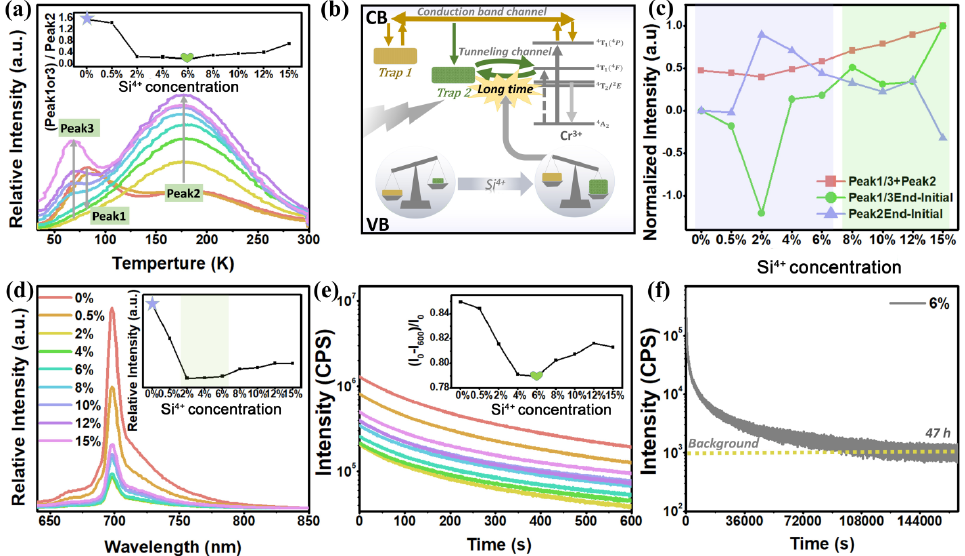
Figure 2. ( a ) The TL spectra of Li 2 ZnGe 3-y Si y O 8 : 0.8%Cr 3+ ( y = 0%-15%); inset: the proportional relationship between the intensity of TL spectra of shallow trap (peak1 or 3) and deep trap (peak 2); ( b ) mechanism of PersL emission on CB channel and TN channel; ( c ) analytical plot of the effect of TL spectral trap distribution on the PersL emission performance (emission intensity and attenuation time) of Li 2 ZnGe 3-y Si y O 8 : 0.8%Cr 3+ ; ( d ) long PersL spectra of L Li 2 ZnGe 3-y Si y O 8 : 0.8%Cr 3+ ; ( e ) PersL decay curve of Li 2 ZnGe 3-y Si y O 8 : 0.8%Cr 3+ ; inset: trend of decay rate of PersL at different y values; ( f ) the PersL attenuation curve of Li 2 ZnGe 3-y Si y O 8 : 0.8%Cr 3+ ( y = 6%).